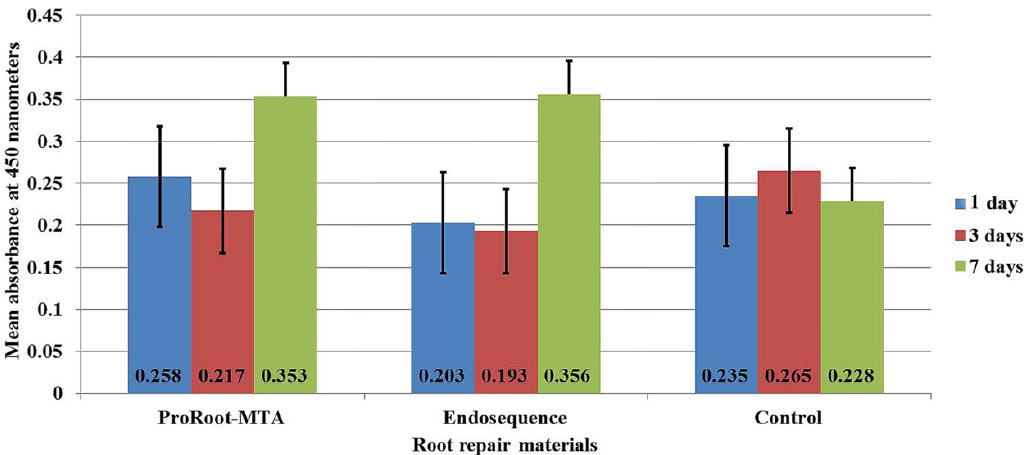
Figure 1. Error bar of means of mesenchymal stem cell viability with and without treatment with root repair material extracts at the different incubation periods.